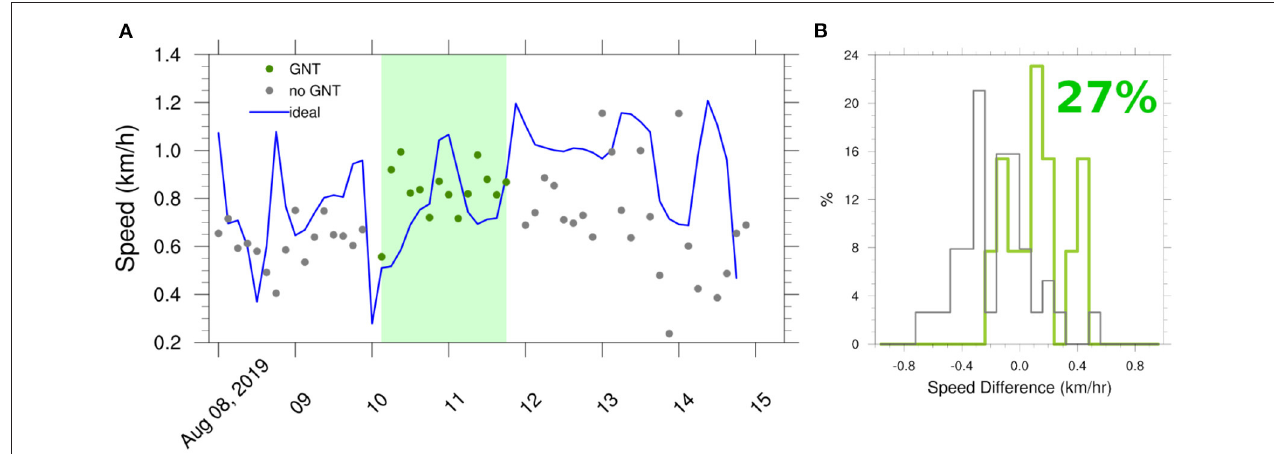
FIGURE 7 | Results of OceanGNS tests for the Gulf of St. Lawrence deployment. (A) Shows the glider speed (dots) toward its intended waypoint (destination) for every dive segment calculated from GPS positions. The green shaded period is the time when OceanGNS was used. The blue line is the calculated ideal speed the glider could achieve based on the constant value of 0.27 m/s and the dead reckoned currents estimated by the glider (Equation 7). (B) Histogram of ideal vs. achieved glider speed toward the target. The residuals of the ideal speed vs. the actual speed toward the waypoint shows that during the OceanGNS test period, the glider speed exceeded the ideal value by an average of